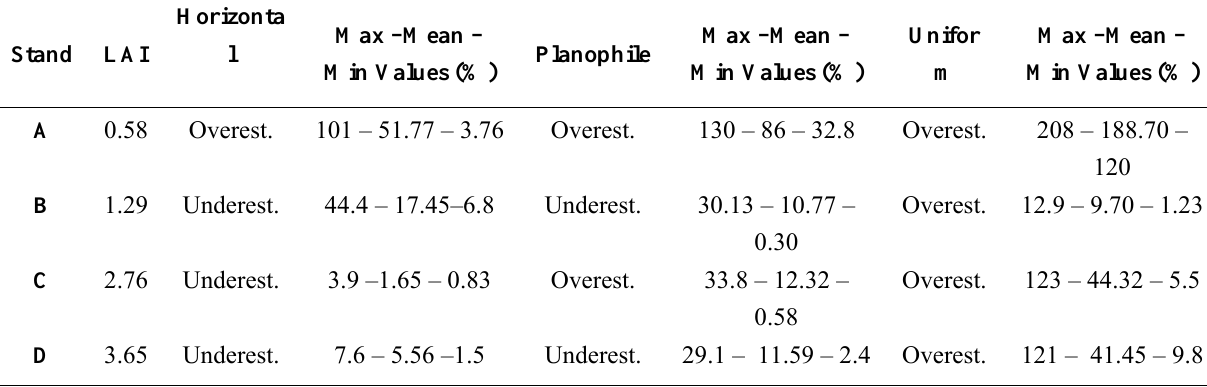
Table 2. Mean, maximum, and minimum APAR percentage differences of multilayer representations versus geometrically explicit 3D